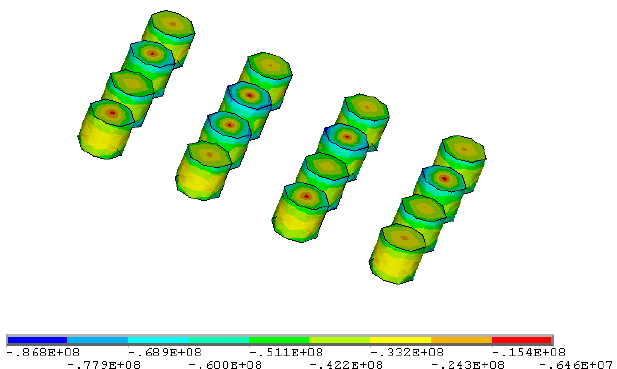
Figure 28. Maximum principal stress distribution in the middle of the pillar at 1480 mL of scheme 6 (parameters of scheme 6: stope height 3.5 m, pillar diameter 4 m, pillar spacing 6 m, pillar row spacing 9 m).